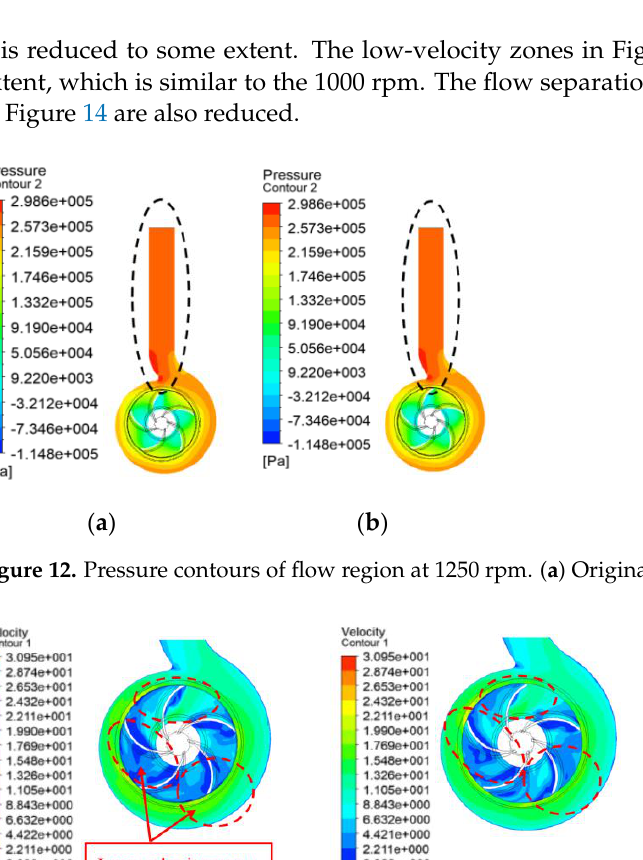
( b ) Figure 10. Velocity contours of flow region at 1000 rpm. ( a ) Original model; ( b ) rounded model. ( a )